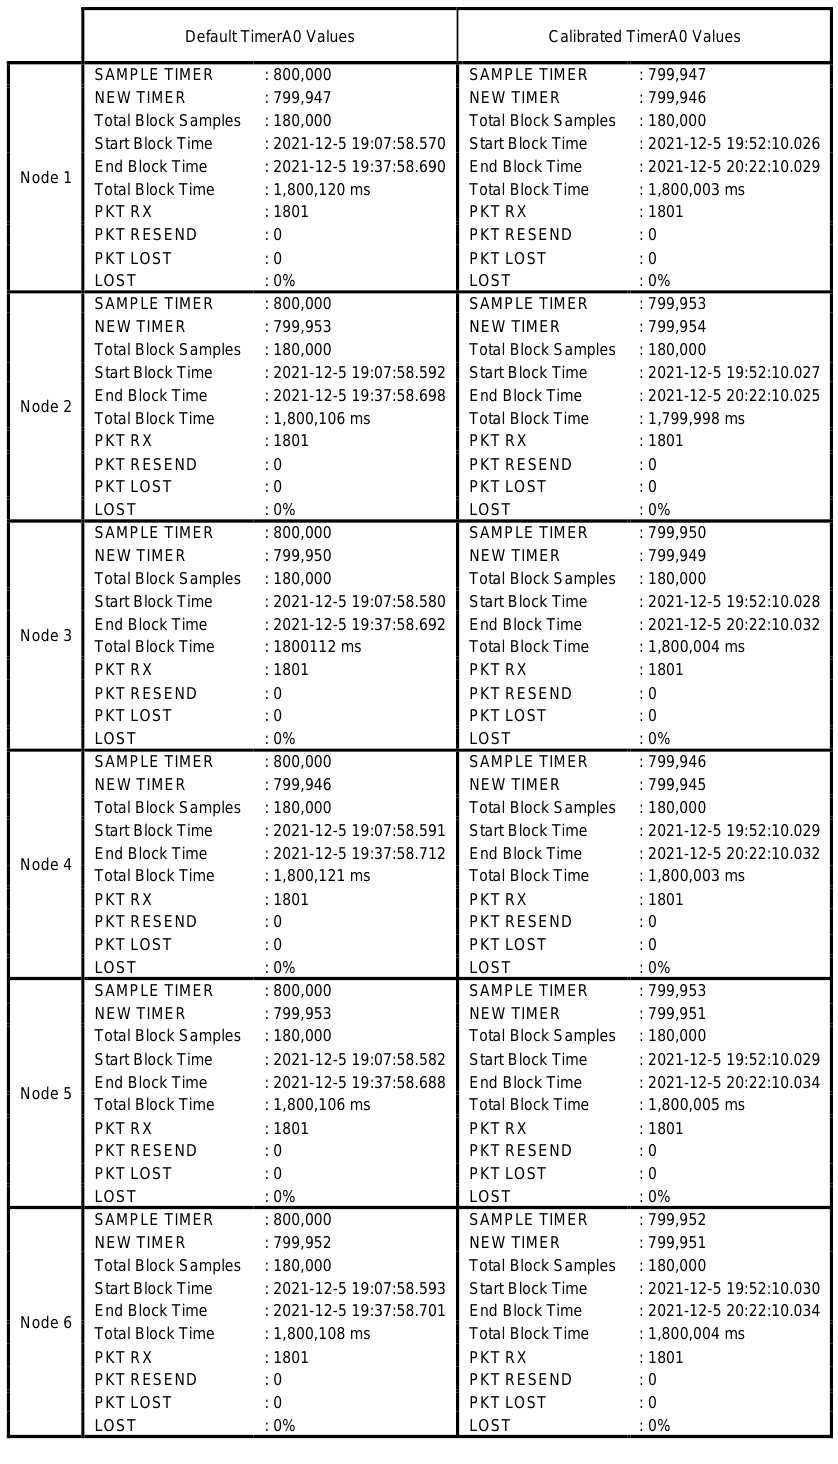
Figure 10. Results of the 30 min register for the six nodes.